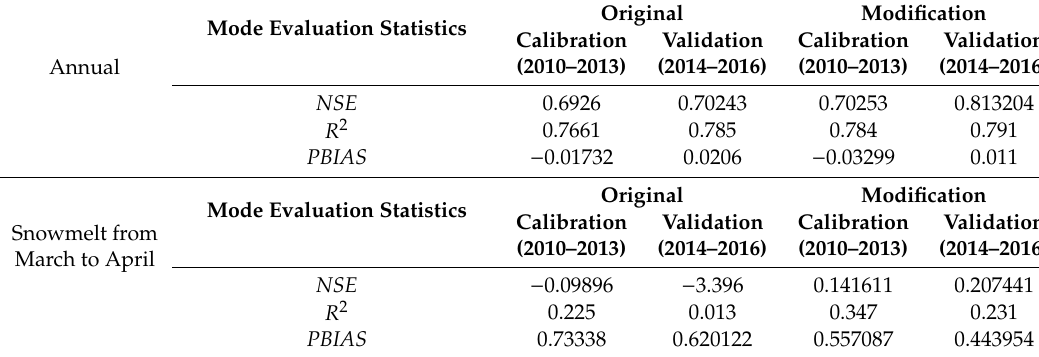
Table 5. Evaluation of